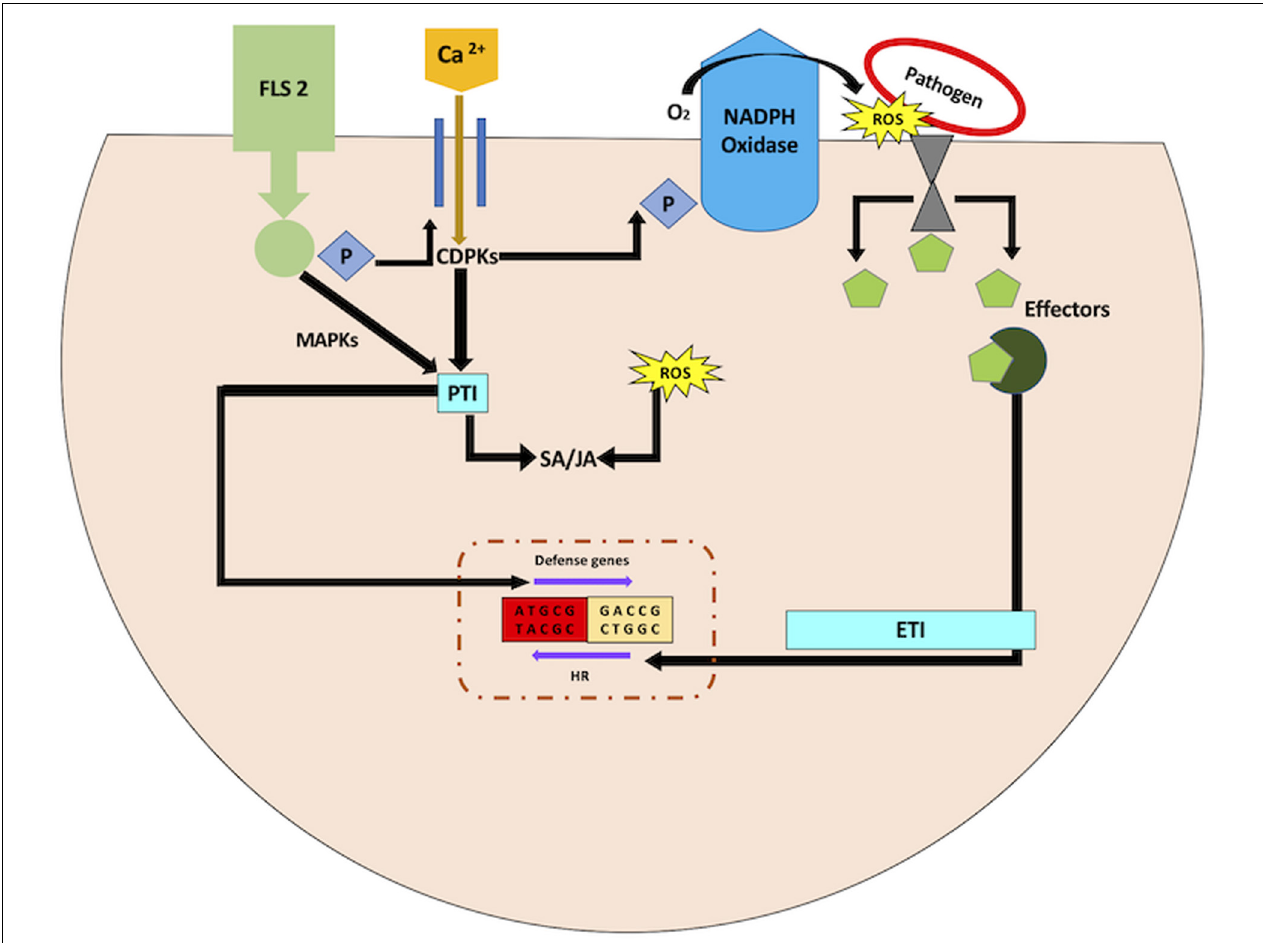
FIGURE 3 | ROS modulation of biotic stress responses. FLS2 receptor kinase triggers the Ca 2 + flux, followed with mitogen-activated protein kinase (MAPK) and Ca 2 + –dependent protein kinase (CDPK) cascades. These initial signals contribute to pathogen-associated molecular pattern (PAMP)-triggered immunity (PTI). Effector molecules are synthesized by host-adapted microbes, which suppress PTI. Plant system under such circumstances specifically identifies effector molecules to activate effector-triggered immunity (ETI). This eventually initiates the hypersensitive response